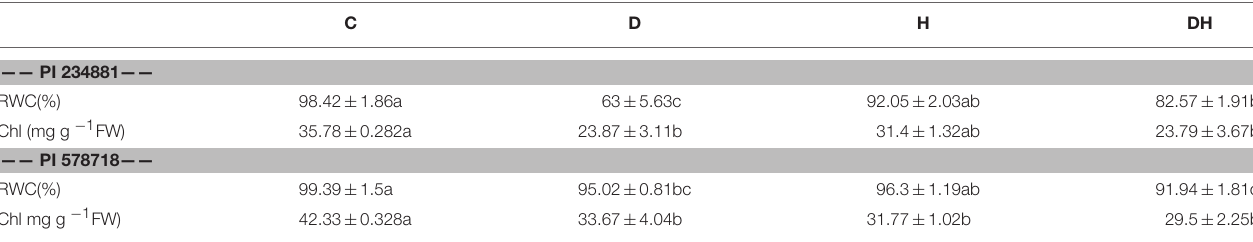
TABLE 2 | Effects of stress treatments on RWC and Chl content of heat sensitive PI 234881 and heat tolerant PI 578718 under control (C), drought (D), heat (H), combined stress